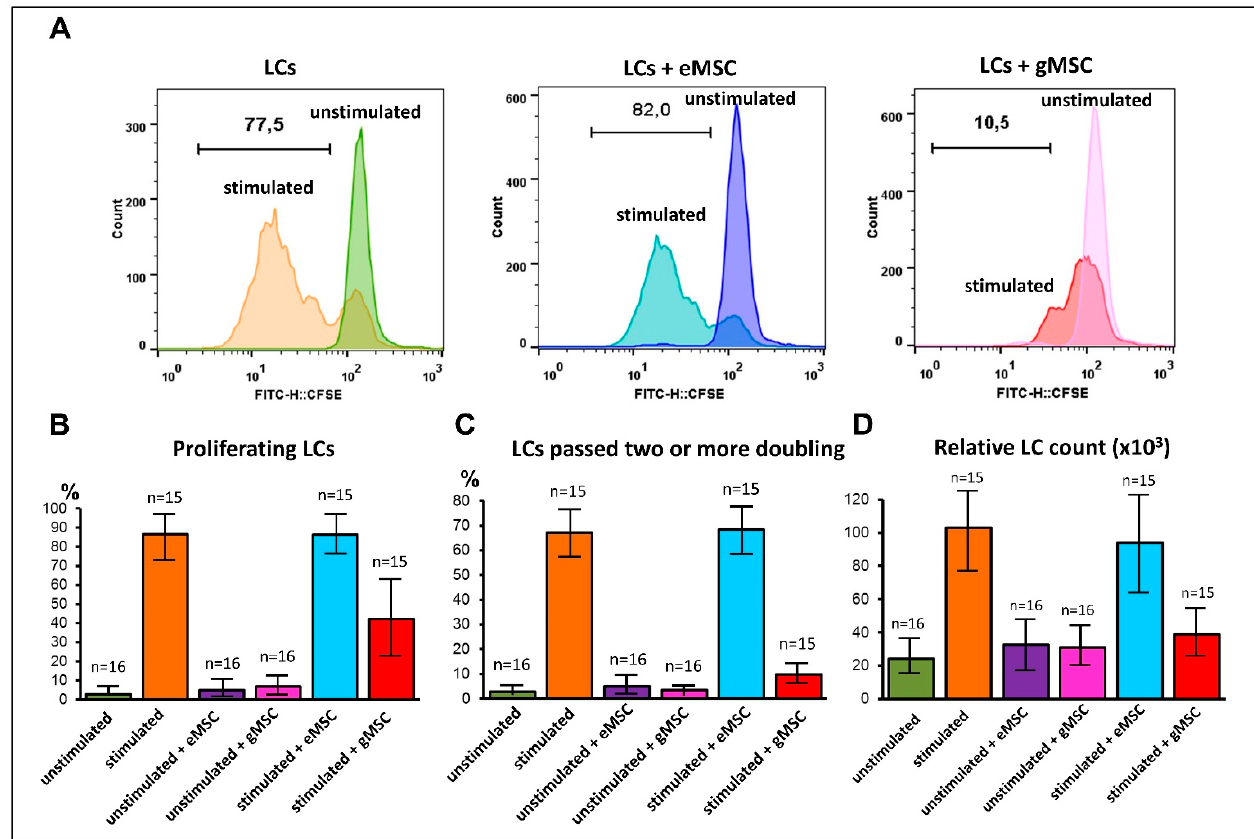
Figure 5. Effects of stromal cells from eutopic or ectopic endometrium upon the proliferation of T-lymphocytes in vitro. Lymphocytes (LCs) were stained with CFSE, stimulated to proliferate with “Dynabeads”, and co-cultured with stromal cells of eutopic (eMSC) or ectopic (gMSC) endometrium (LCs/MSC ratio 10:1). After 4 days in co-culture, the cells were analyzed by flow cytometry to evaluate CFSE distribution and relative LSs counts. ( A ) distribution of CFSE in MSC-6 co-cultures (typical histograms). ( B – D ) Processed data combining all the measurements of six pairs of the MSC co-cultures. ( B ) The percentage of proliferating LCs. ( C ) The percentage of proliferating LCs having passed two or more doubling. ( D ) Relative LCs counts. Whiskers represent